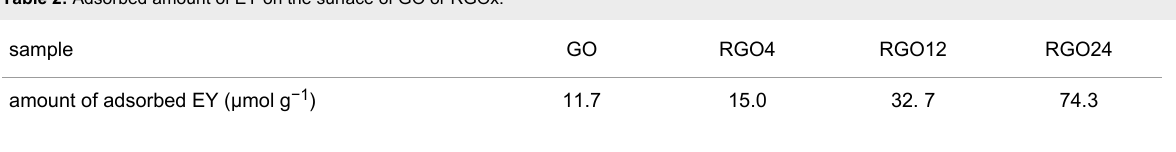
Table 2: Adsorbed amount of EY on the surface of GO or RGOx. sample